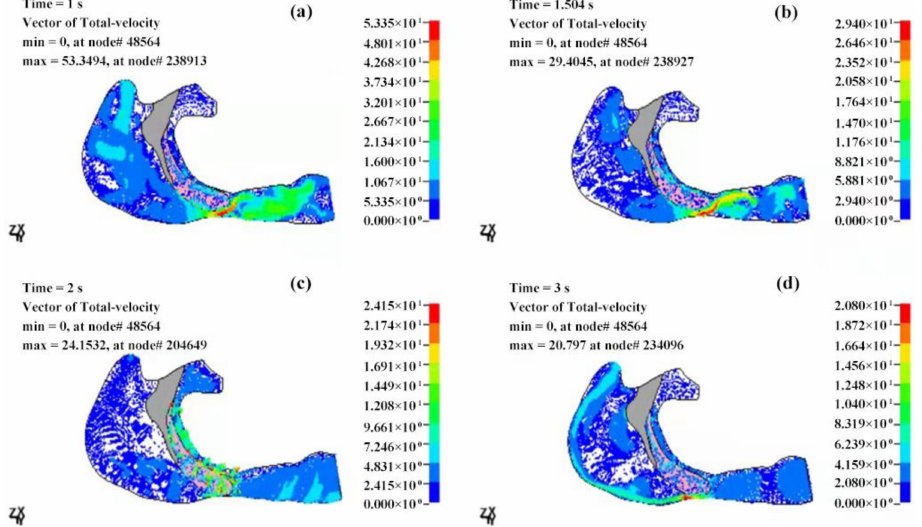
Figure 13. The velocity distributions of the fluid field of the OSAHS patient’s upper airway under the state of apnea (velocity unit in m/s). ( a , b ) The inspiration phase; ( c , d ) the expiration